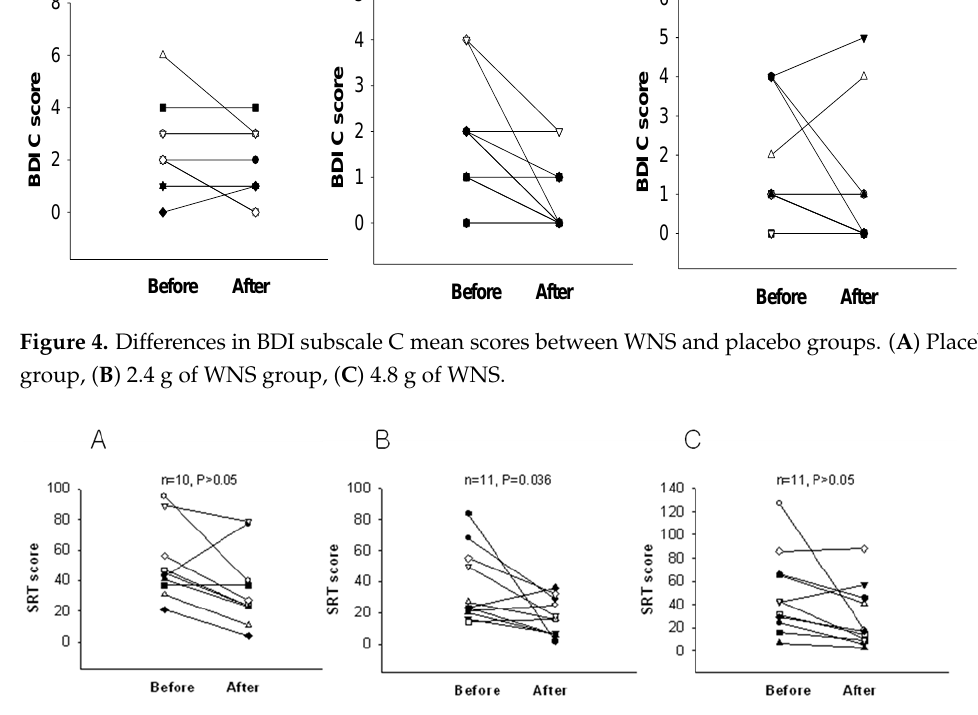
Figure 6. Differences in SRI E mean scores between WNS and placebo groups. ( A ) Placebo group, (B) 2.4 g of WNS group, ( C ) 4.8 g of WNS group. 3.3. Resting EEG Asymmetry The analysis carried out on EEG power spectral content showed differential effects for each EEG band with marked topographical differences. As depicted in Figure 7, the alpha – beta ratio was significantly increased in both WNS 2.4 g and 4.8 g treatment groups. Figure 7. Asymmetry values with depressive disorder after WNS and placebo treatment. (A) 2.4 g of WNS group, (B) placebo group, (C) 4.8 g of WNS. 4. Discussion